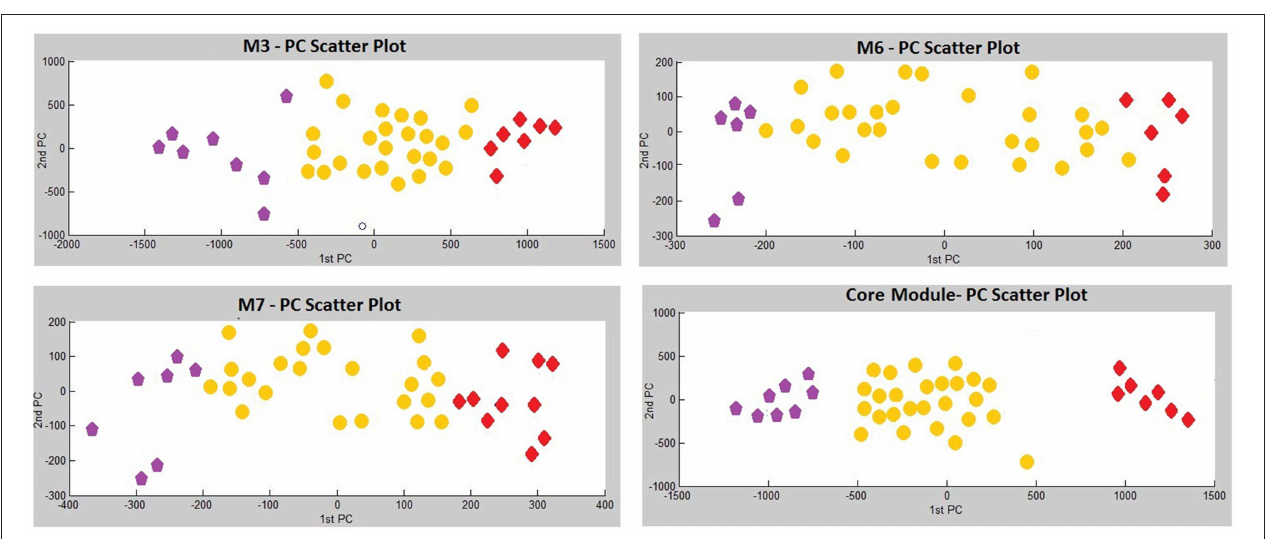
Frontiers in Endocrinology |